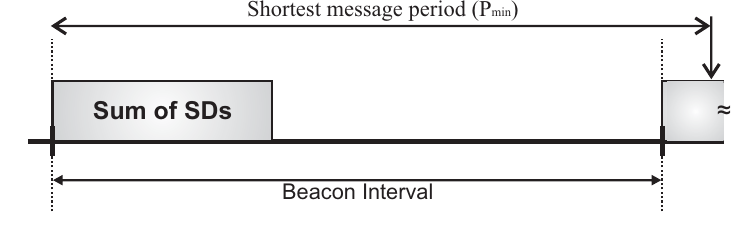
Figure 6. Longest Beacon